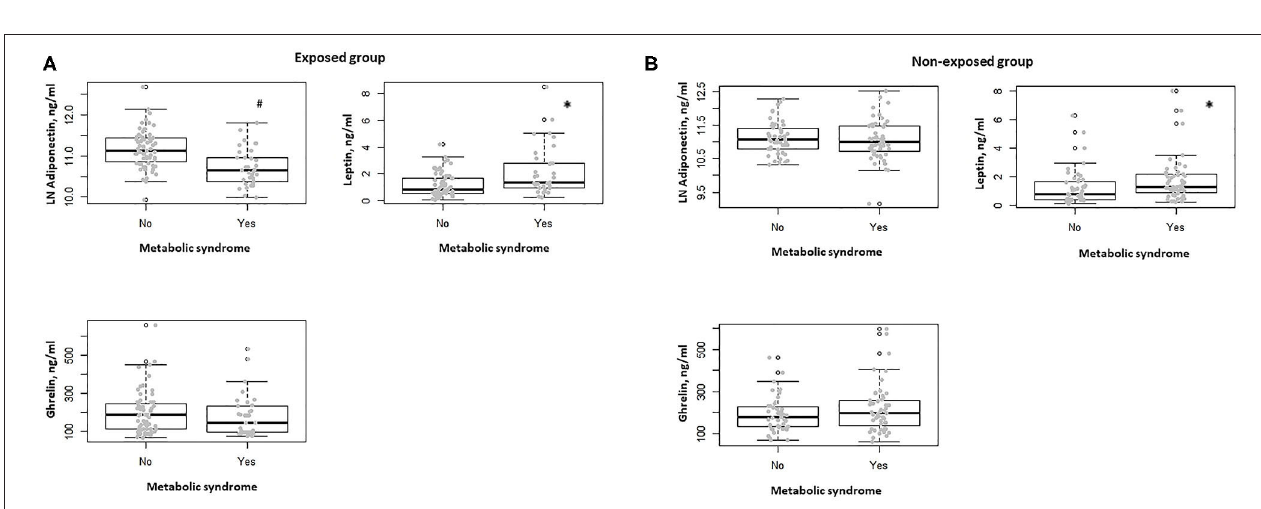
FIGURE 2 | (A) Box-dot plot of serum adiponectin, ghrelin, and leptin levels in the exposed group in subjects with ( n = 32) and without metabolic syndrome ( n = 68). * P = 0.002, # P < 0.0001. (B) Box-dot plot of serum adiponectin, ghrelin, and leptin levels in the non-exposed group in subjects with ( n = 52) and without metabolic syndrome ( n = 47). * P =